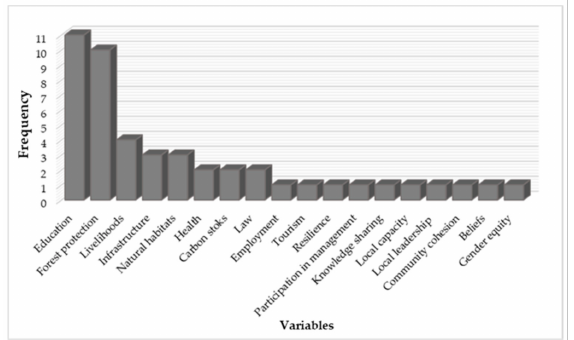
Figure 3. Variables perceived to be affected by the PES project and their importance according to quotes of participants.